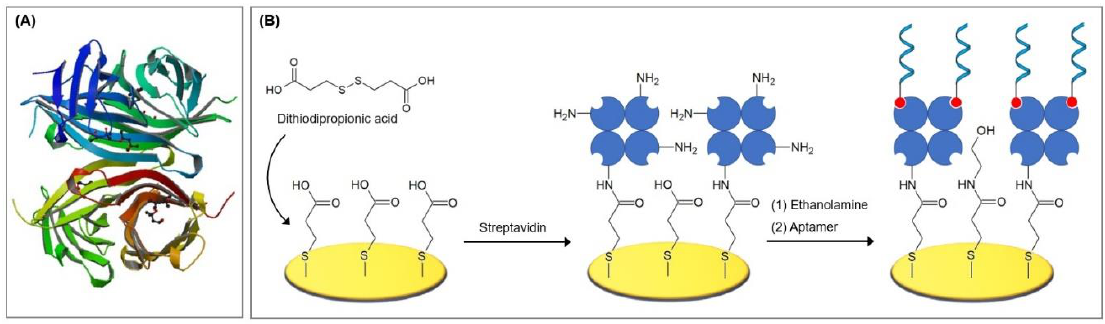
Figure 19. ( A ) Tetrameric streptavidin binding biotin molecules, reprinted from the paper [118]. ( B ) Human osteopontin aptasensor utilizing the streptavidin / biotin interaction